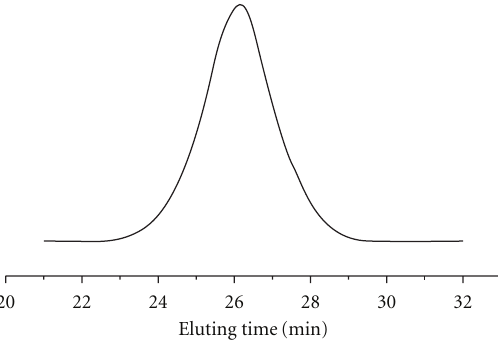
Figure 8: GPC trace of the block copolymer of PLLA- b